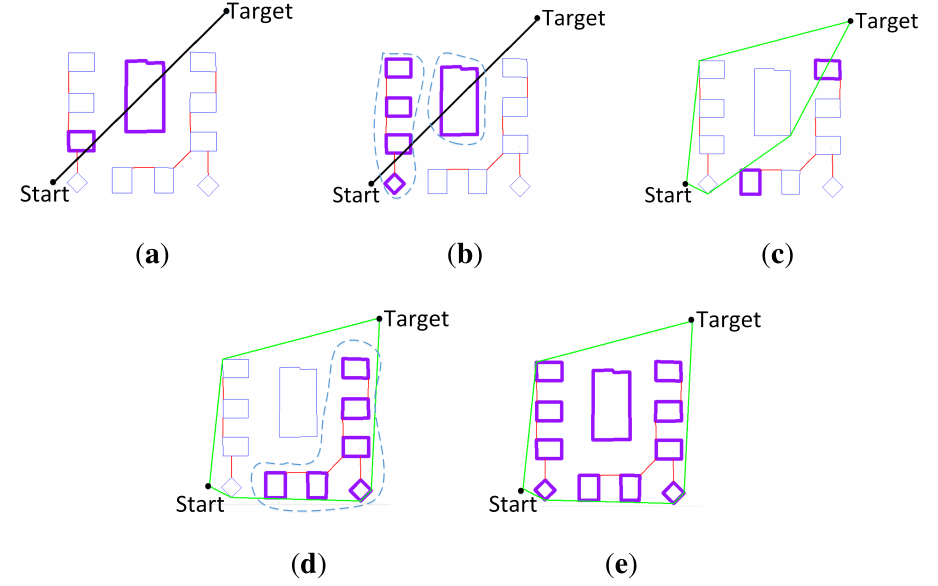
Figure 8. Selecting obstacle groups with respect to the start and target location of a